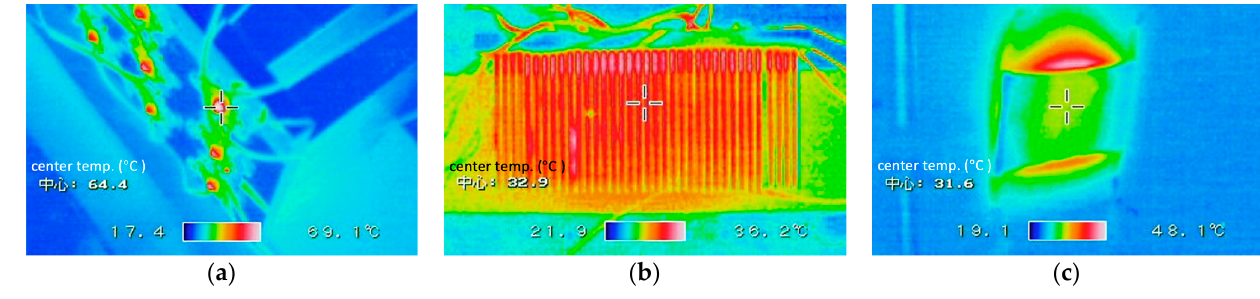
Figure 8. Thermal image and center temperature (temp.): ( a ) LED; ( b ) heat sink; ( c ) solar cell.